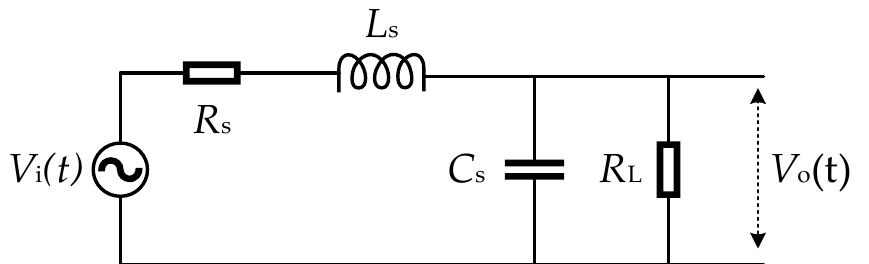
Figure 3. The equivalent circuit.